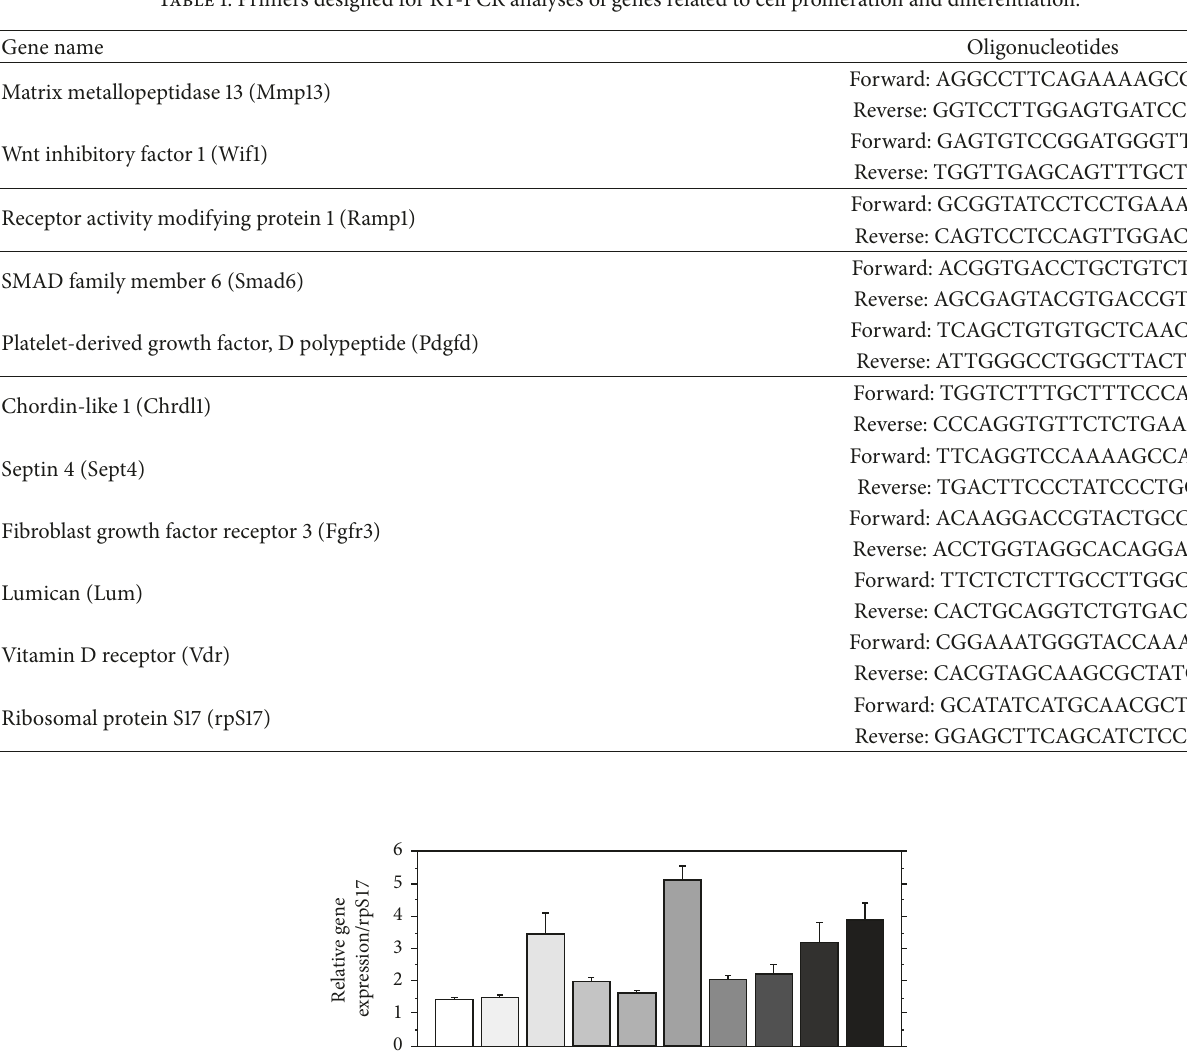
Table 1: Primers designed for RT-PCR analyses of genes related to cell proliferation and differentiation.